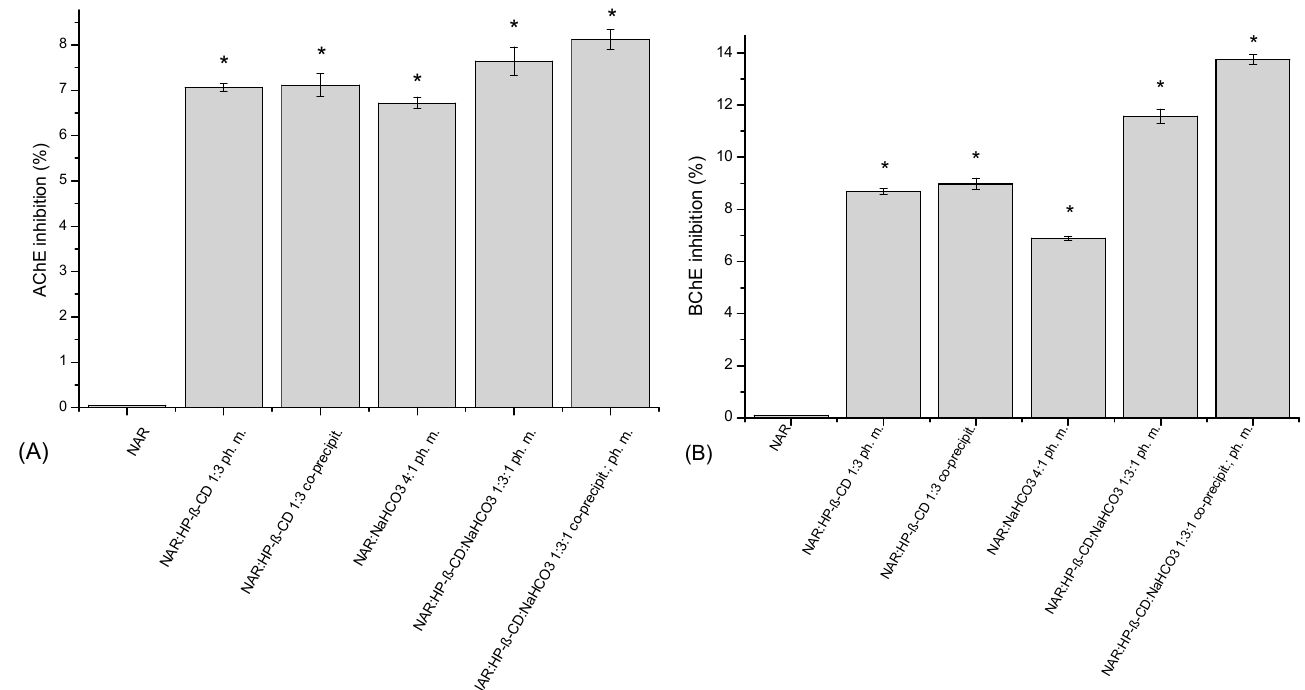
Figure 6. AChE ( A ) and BChE ( B ) inhibitory activity of NAR, the binary system (NAR:HP- β -CD) obtained by the co-precipitation method, the physical mixtures (NAR:HP- β -CD; NAR:NaHCO 3 ), the ternary system (NAR:HP- β -CD:NaHCO 3 ), and the physical mixture (NAR:HP- β -CD:NaHCO 3 ). (*) indicates statistically significant differences, p < 0.05. NAR at the concentration of 2.520 μ g/mL did not inhibit BChE (Figure 6). However, ph. m. or a system with HP- β -CD in the ratio 1:3, by elevating the water concentration of NAR to 506.29 μ g/mL and 542.11 μ g/mL, allowed enzyme inhibitions of 8.70 ± 0.15% and 8.98 ± 0.22%, respectively, to be reached. The addition of NaHCO 3 to the binary system